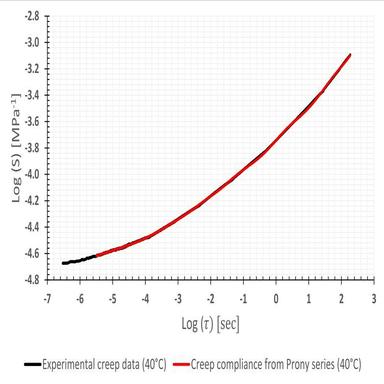
Experimental creep compliance master curve and creep compliance reconstructed using Prony series at 40 °C.